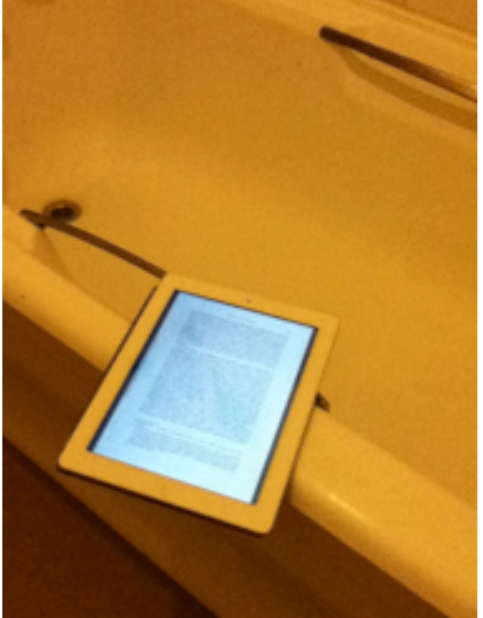
Figure 3: Yuki’s image of her iPad on the